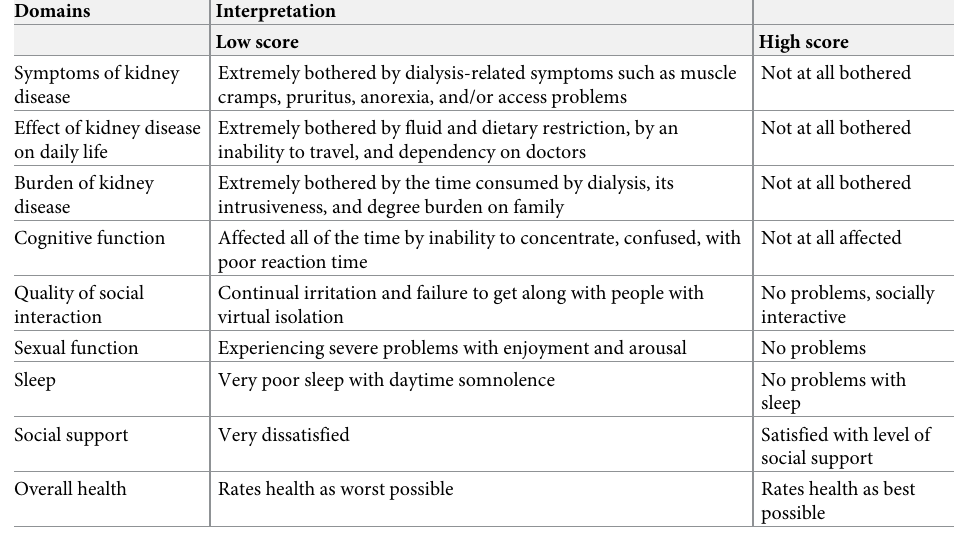
Table 1. Explanation of the Kidney Disease Quality of Life-Short Form (KDQOL-SF) kidney disease-specific domains.